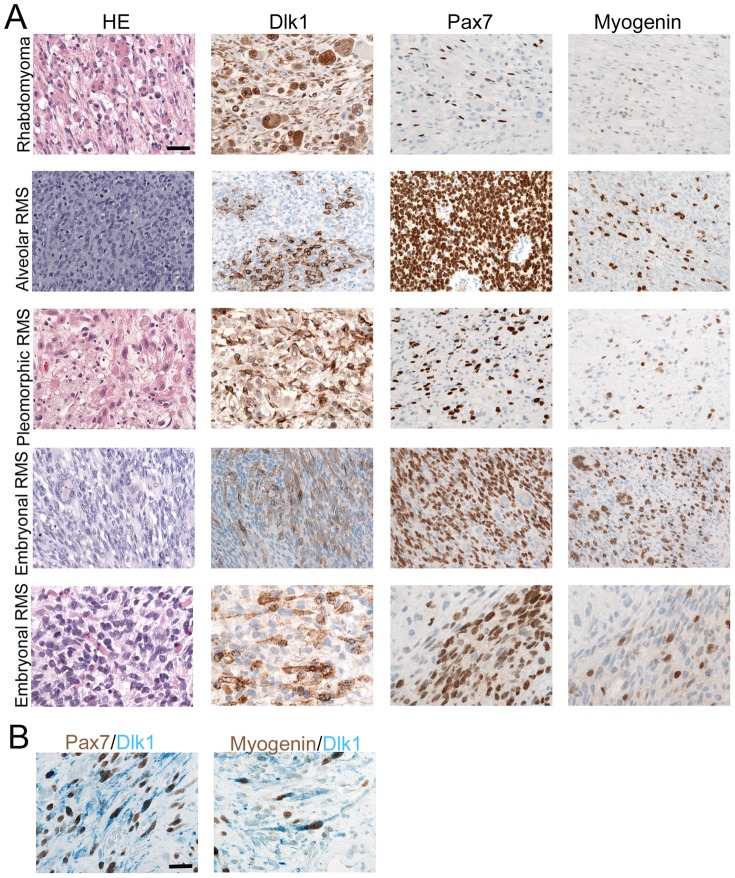
Immunohistochemical analysis of skeletal muscle tumors.A: Biopsies from rhabdomyoma and the 3 rhabdomyosarcoma subtypes, alveolar, pleomorphic and embryonal, were analyzed for expression of Dlk1, Pax7 and Myogenin. Dlk1 was strongly expressed by all skeletal muscle tumor types and can thus be considered a solid marker. Expression of Pax7 and Myogenin in all tumors confirmed the skeletal muscle origin. Scalebar representative for all images: 50 µm. B: Dlk1 expression was detected specifically in cells co-expressing either Pax7 or Myogenin, shown as double staining. Two examples of rhabdomyosarcomas with these co-expression patterns are shown. Scalebar representative for all images: 50 µm.